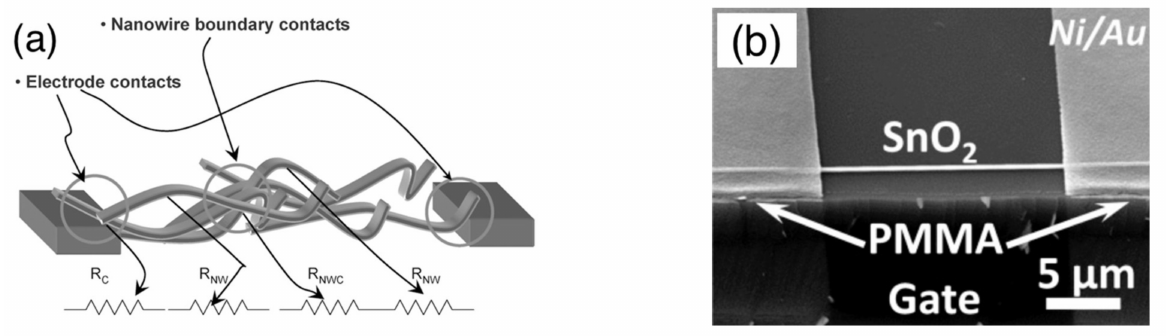
Figure 3. Types of nanowire-based chemiresistors: ( a ) Schematic representation of a chemiresistor based on a disordered network of nanowires and the main components of the equivalent electrical circuit; ( b ) SEM image of a chemiresistor based on a single nanowire contacted by two electrodes. Figure 3a is reprinted from [34], Copyright (2010), with permission from Elsevier. Figure 3b is from